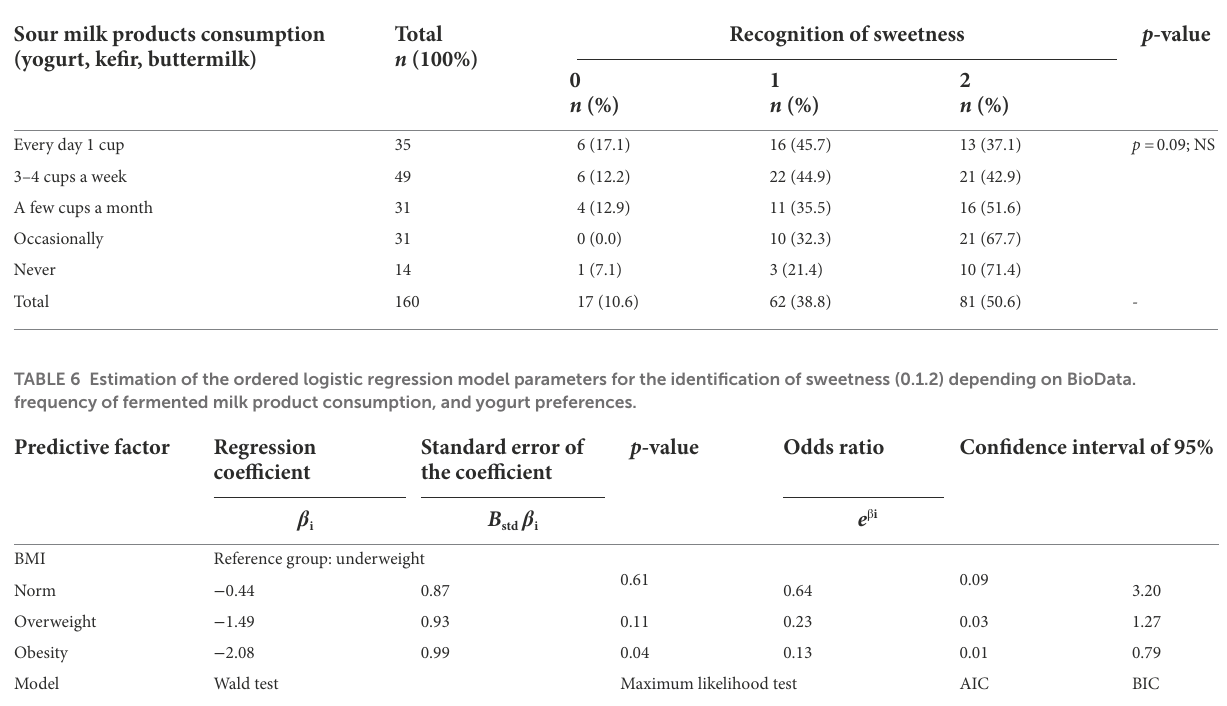
TABLE 5 Results of the sweetness recognition test taking into account the frequency of fermented milk product consumption. Sour milk products consumption (yogurt, kefir, buttermilk)